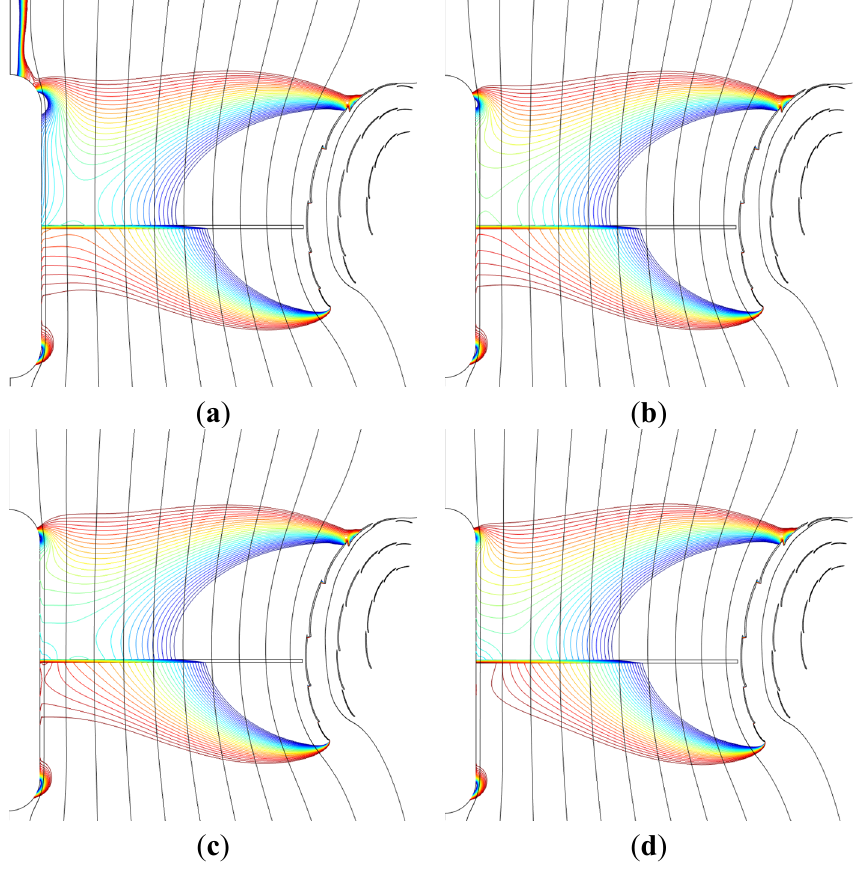
Figure A1. Low loading: Streamlines and fixed-range selection of pressure contour lines for the multi-element DAWT at a low C T thrust loading of 0.32. Left plots: TSR = 2. Right plots: TSR = 10. Upper plots: Ideal inner-blade section with constant thrust loading (case 3). Lower plots: Cylindrical inner-blade section with drag and ramped-down thrust loading (case 4). In the presence of a sufficiently adverse pressure gradient on the centerbody surface downstream of the disk, flow separation (centerbody stall) will occur. Neutral